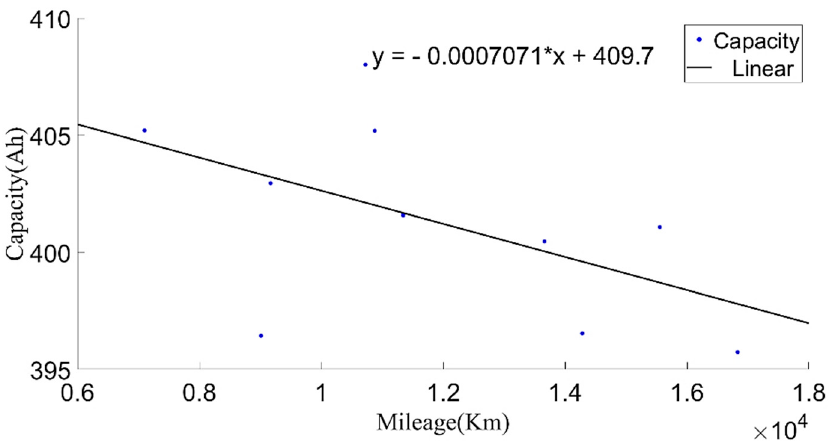
Figure 13. The relationship between the current capacity and the mileage at the charging temperature of 35 °C.